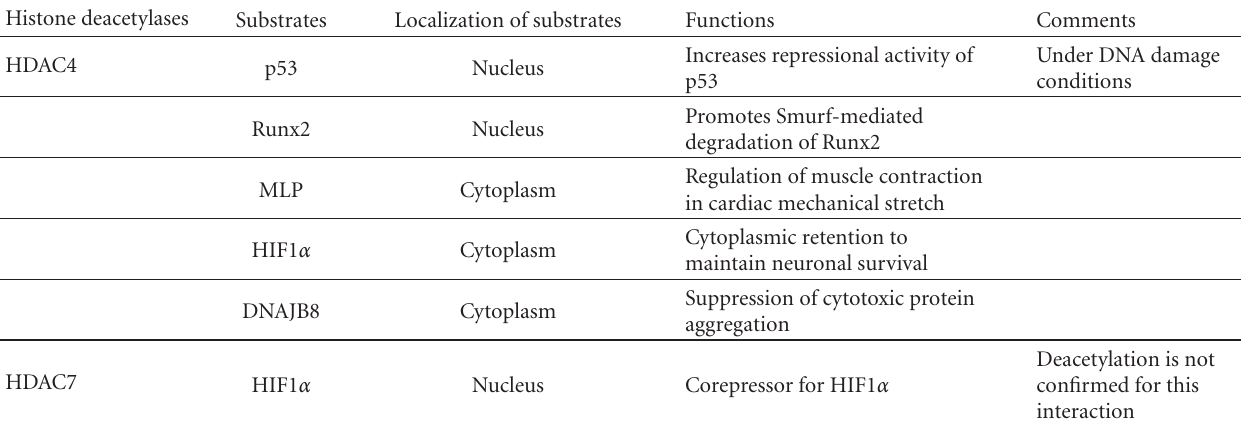
Table 2: Subcellular localization and functions of nonhistone substrates of HDAC4 and HDAC7. Histone